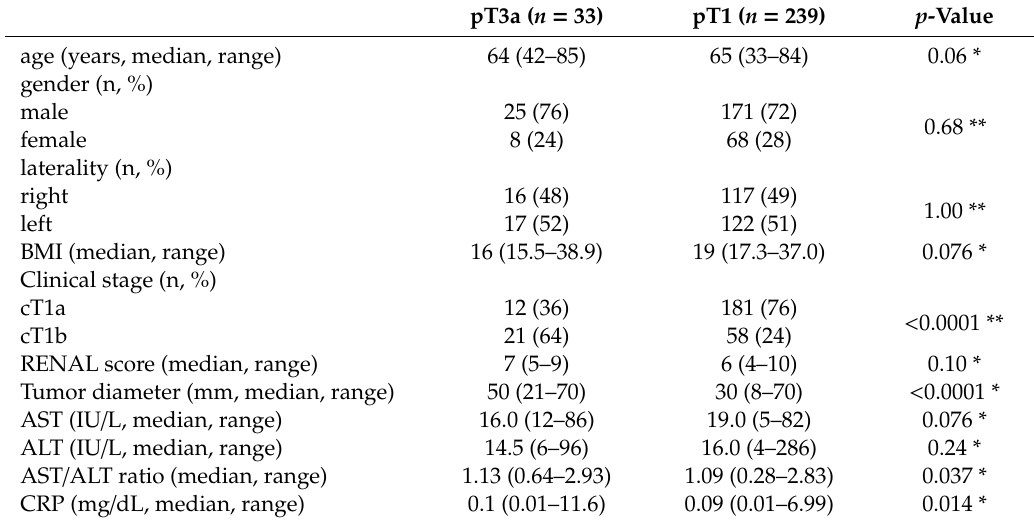
Table 2. The di ff erences of the preoperative parameters between pT3a and pT1 groups.